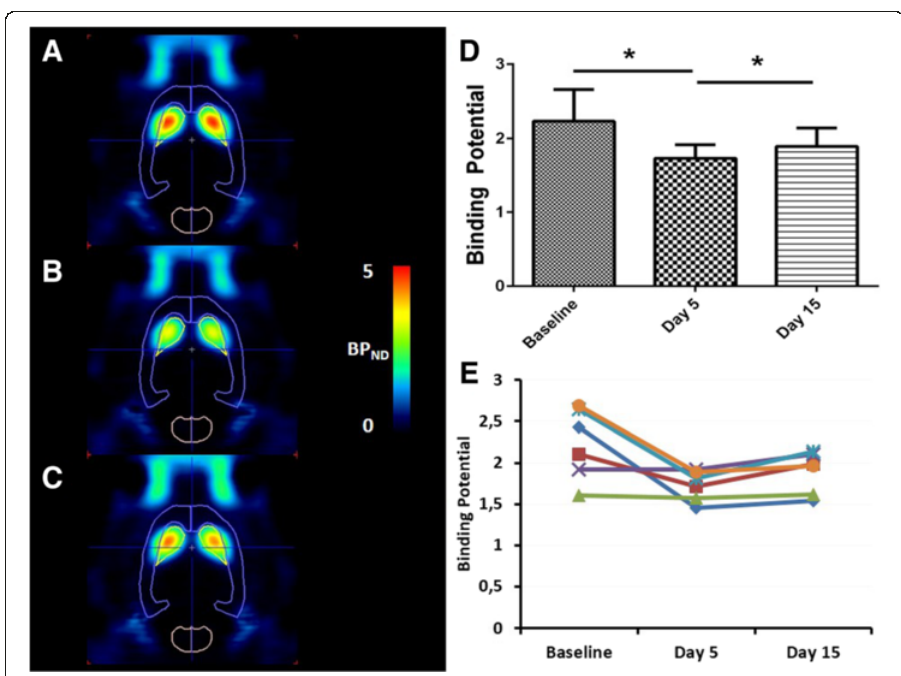
Fig. 4 [ 18 F]JNJ42259152 BP ND values after 5 days treatment with amphetamine and SCH23390. Left : Transversal images of PDE10A binding in the brain. Images are overlaid on a VOI map and presented as averaged, parametric BP ND images (Logan Reference) at baseline conditions ( a ), at day 5 ( b ) and day 15 ( c ) of the experiment. Right : Averaged ( d ) and individual ( e ) BP ND values in striatum of SCH23390 + amphetamine treated rats at baseline conditions, after 5 days of amphetamine treatment (day 5) and after 10 days of washout (day 15). Each line represents a repeated measurement in a single rat at different stages of treatment. Averaged data are presented as mean±SD. Wilcoxon matched pair test; * p